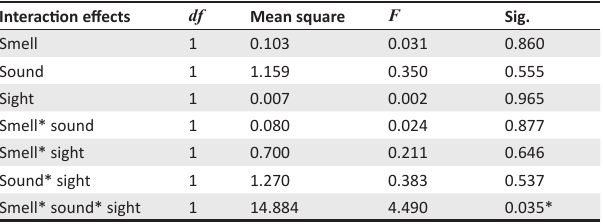
TABLE 2: Analysis of variance